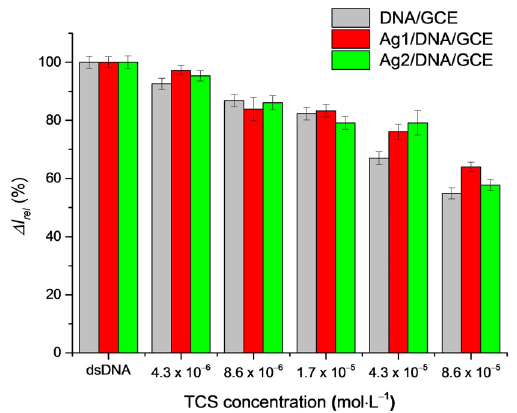
Figure 5. The amount of survived surface attached dsDNA expressed by its relative guanine moi- ety SWV peak current response in dependence on the concentration of TCS used at the 15 min in- cubation of DNA/GCE, Ag1/DNA/GCE and Ag2/DNA/GCE in TCS